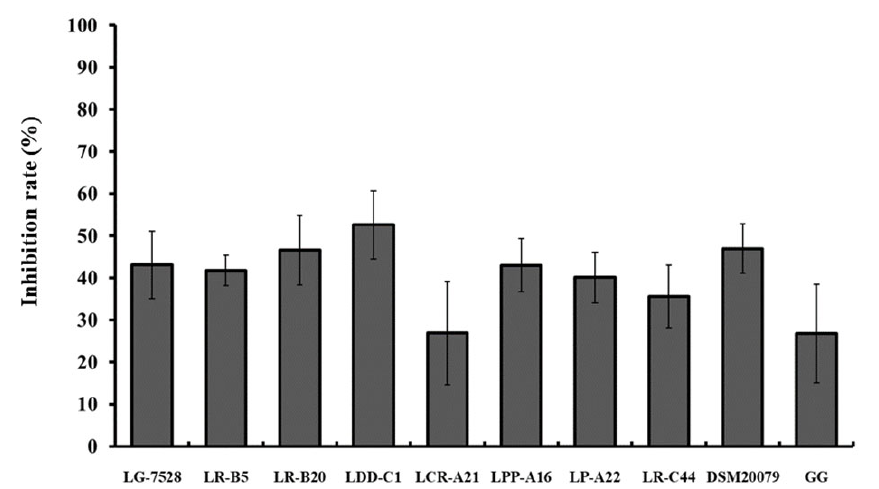
Figure 6. Effect of different lactobacilli strains on Caco-2 invasion by L. monocytogenes EGDe in an exclusion assay, where the Caco-2 cells were pre-treated with Lactobacillus spp. for 1 h before the addition of L. monocytogenes EGDe. Data represent the mean values ± standard error of the mean (SEM) of three biological and two technical replicates.